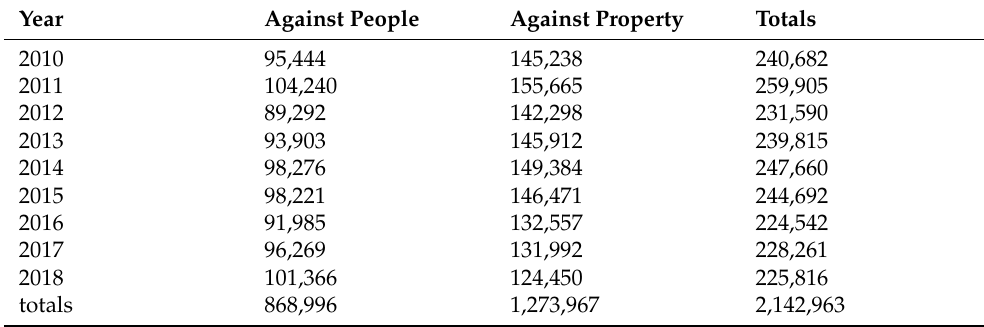
Table 5. Distribution of crimes by type (see Table 4) and year.